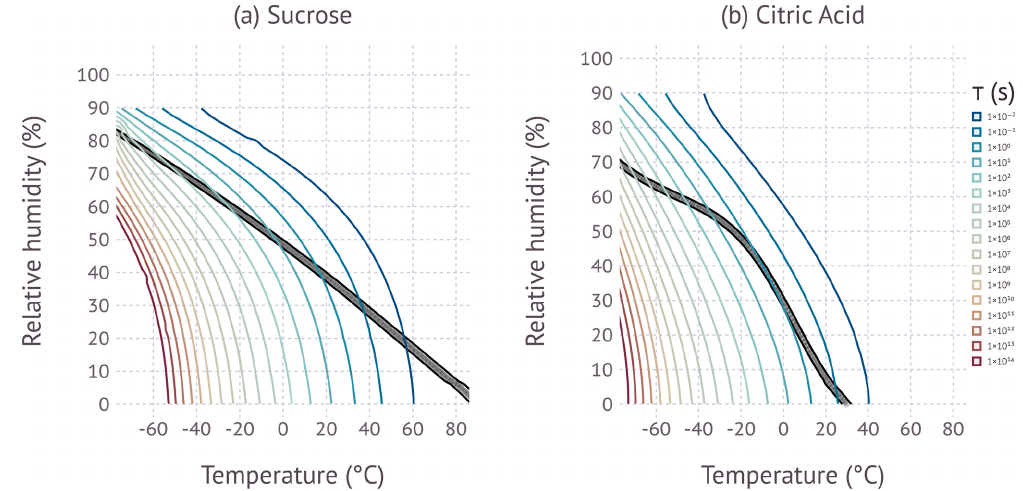
Figure 5. Colored lines correspond to the equilibration timescale as predicted by the KM-GAP model simulations. The black-shaded area shows the region between 5 × 10 6 to 4 . 8 × 10 7 Pas for sucrose, and 5 × 10 6 to 4 . 8 × 10 7 Pas is for citric acid. The contours are limited to − 60 ◦ C < T < 80 ◦ C and 0% < RH < 90% due to numerical instability outside this